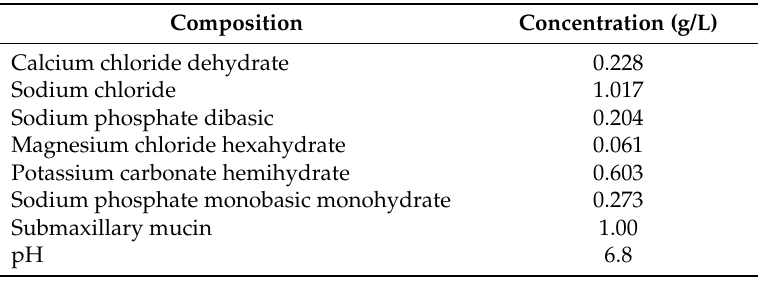
Table 1. Simulated saliva (SS) compositions used in this study [31].